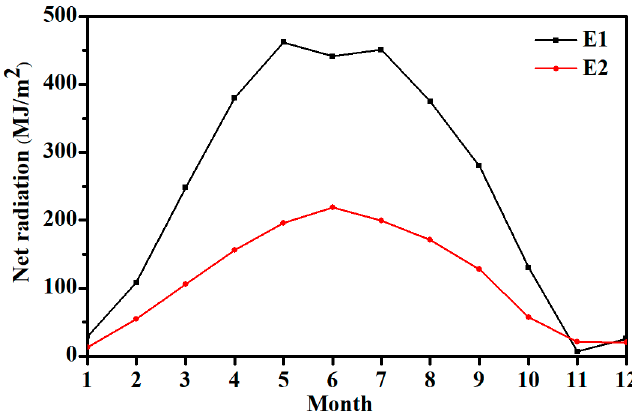
Figure 5. Seasonal net radiation of E1 and E2 stations in the BJD.